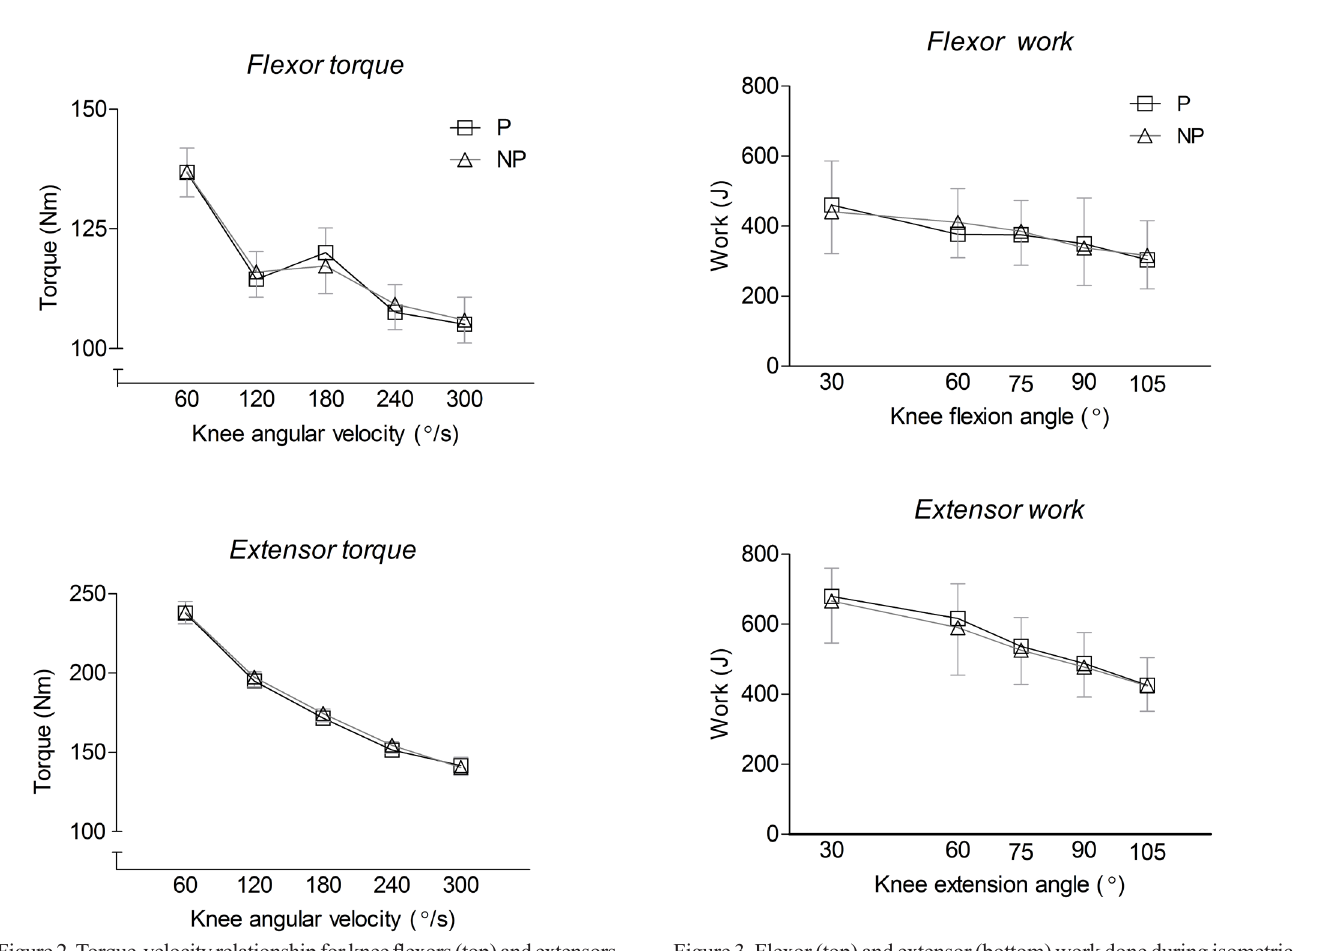
Figure 3. Flexor (top) and extensor (bottom) work done during isometric contractions at different joint